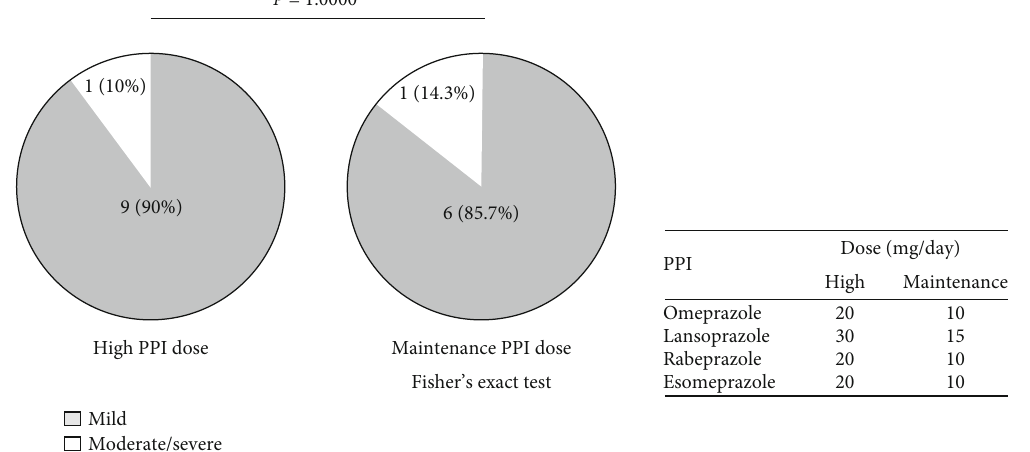
Figure 2: Comparisons of the frequencies of nonvariceal upper gastrointestinal bleeding (UGIB) between 10 patients with high-dose and seven patients with maintenance dose of daily proton pump inhibitor (PPI) consumption. The proportion of patients with mild UGIB was similar between the low- and high-dose PPI